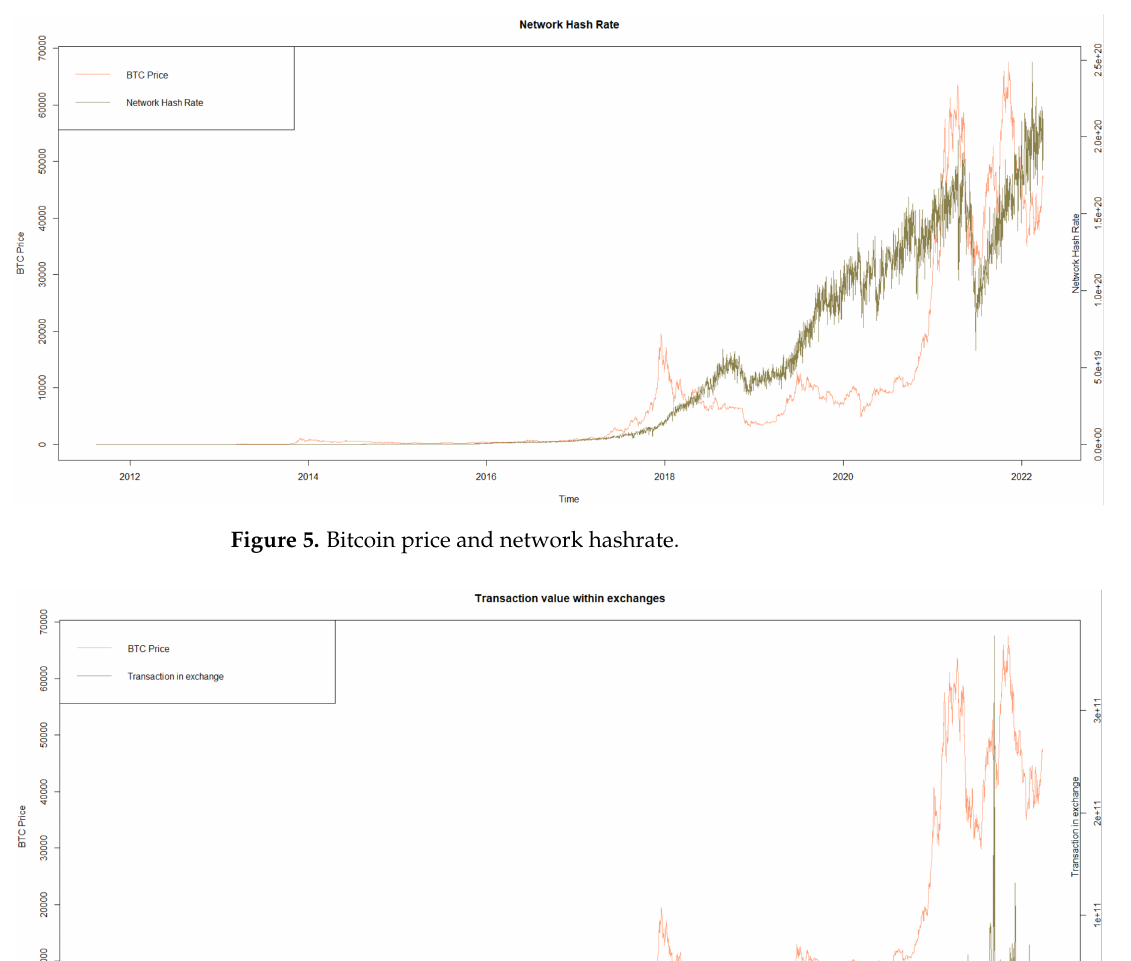
Figure 4. Bitcoin price and active addresses.